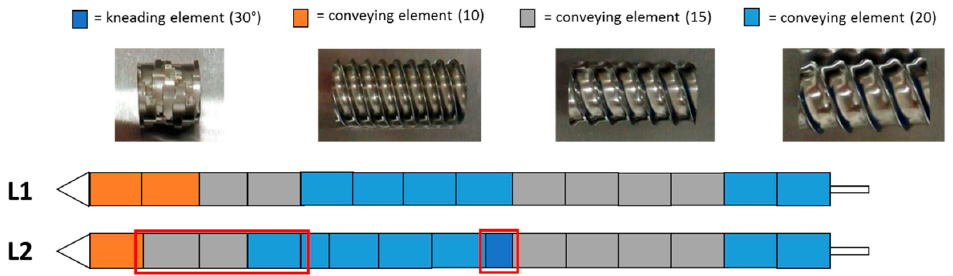
Figure 1. Configuration of the two different screw designs (L1 and L2) used in the present extrusion DoE. The red boxes highlight the differences between the L1 and L2 configurations.